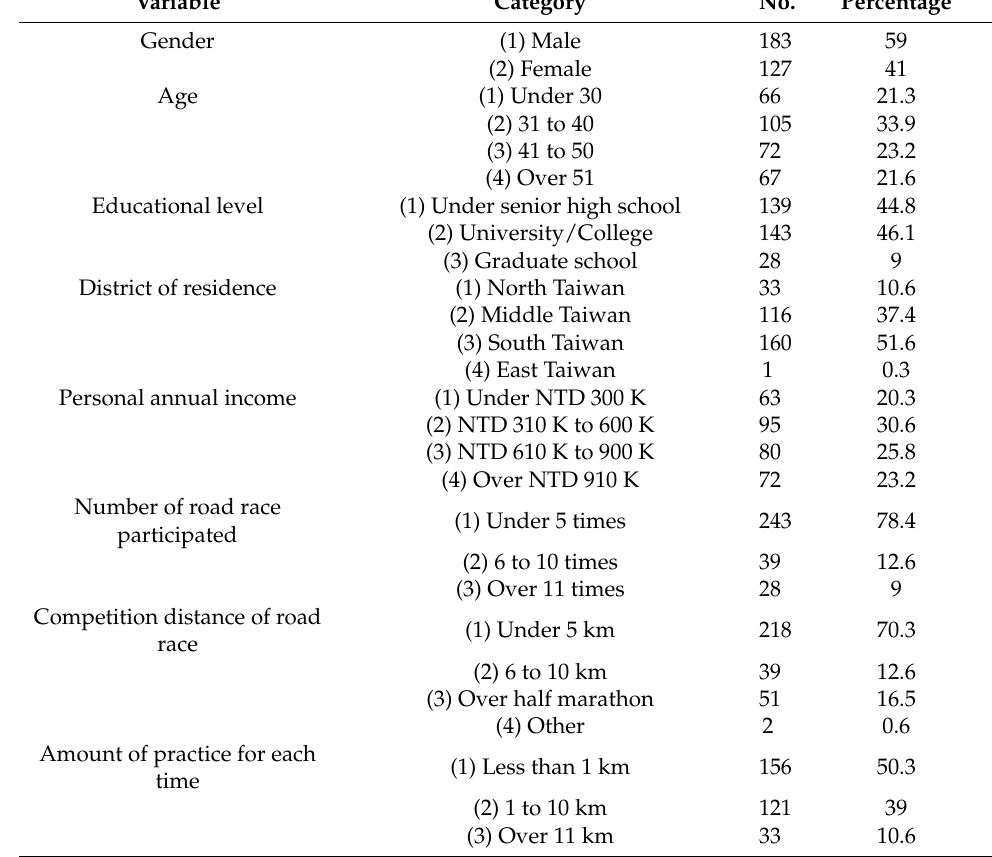
Table 1. Sociodemographic variables and medical history from the